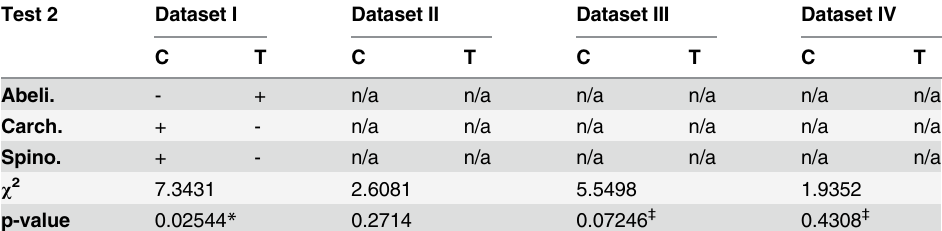
Table 3. Results of Chi-square Test 2 as presented by software R.